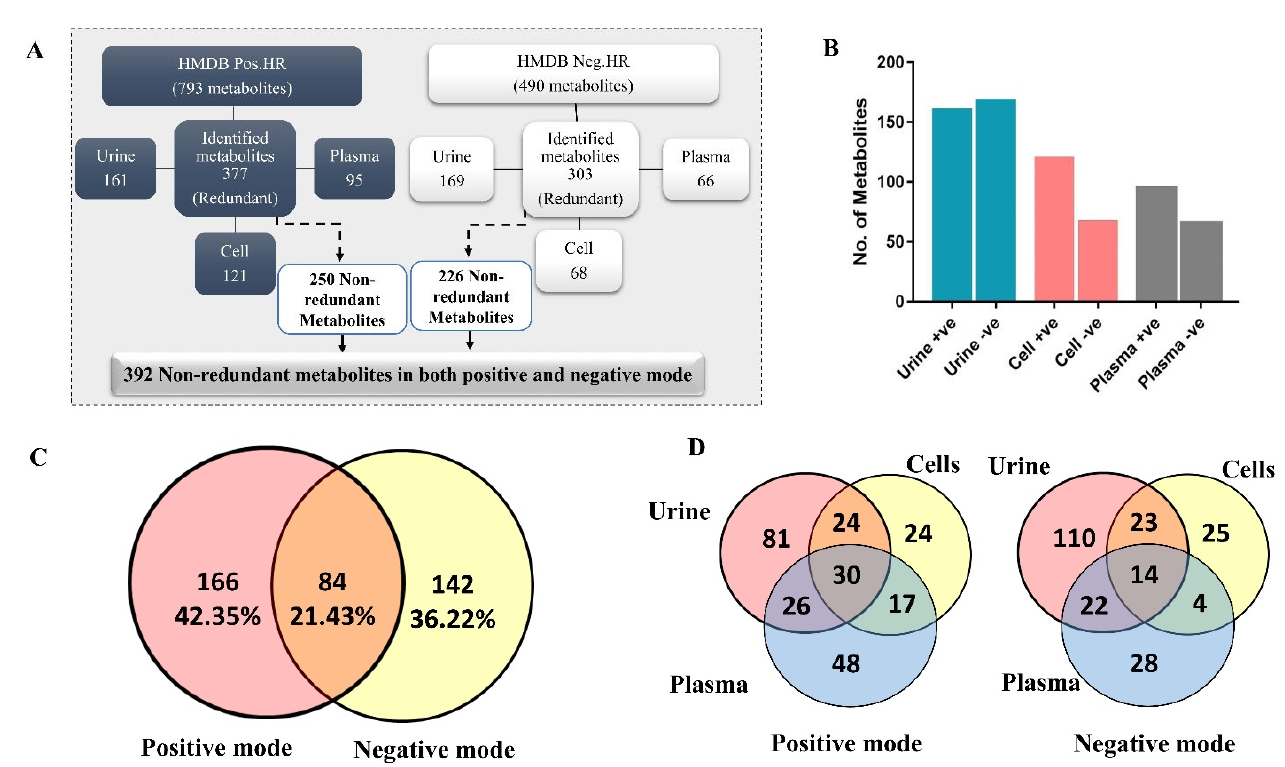
Figure 7. Biological sample analysis using the validated pipeline. ( A , B ) The identified molecules per biological sample. ( C , D ) The overlapping per mode or sample type.